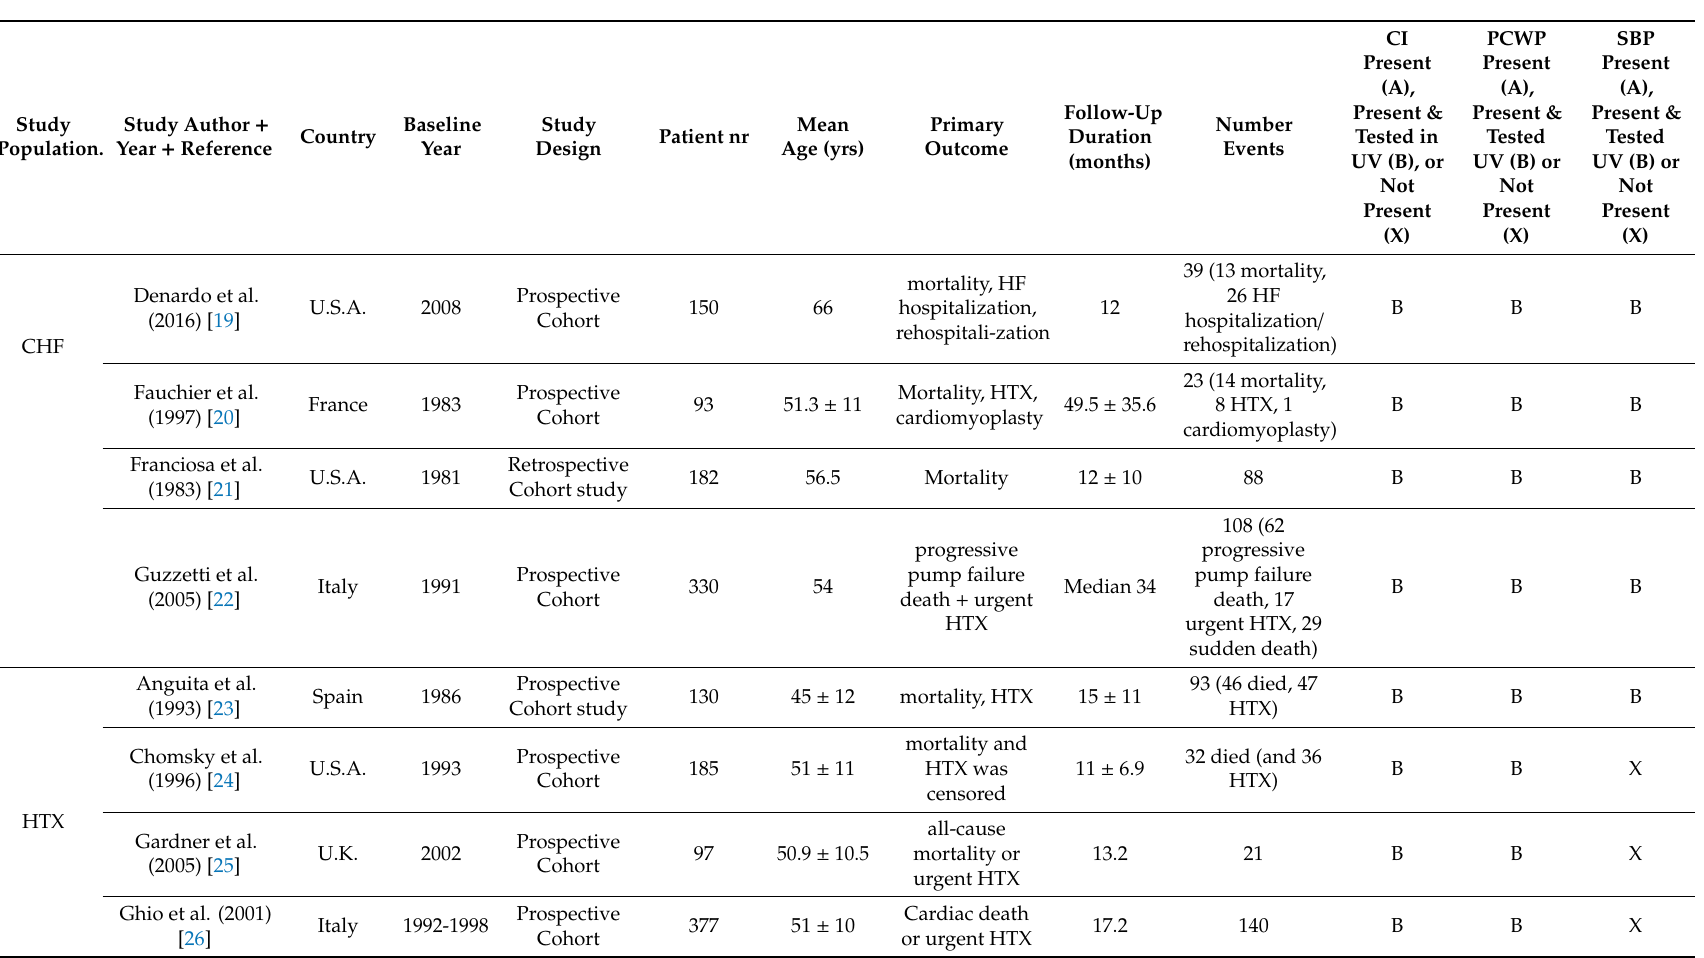
Table 1. Baseline table of selected